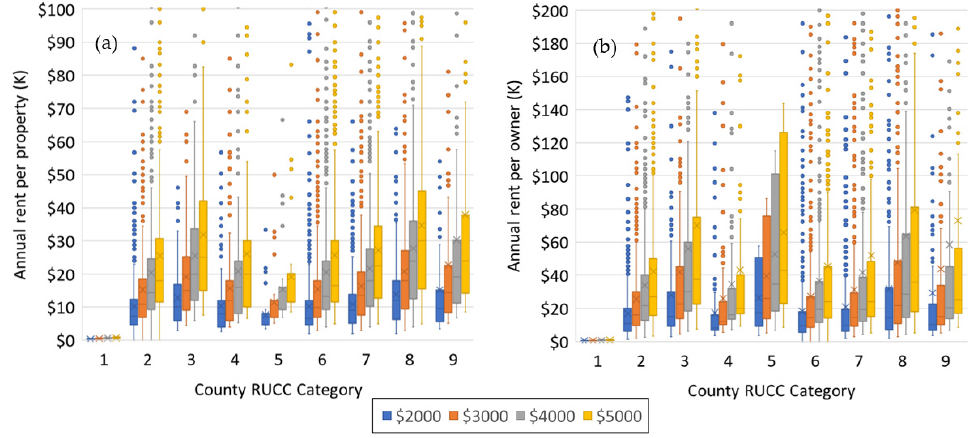
Figure 15. Assessment on the annual rent payments from wind turbine installed on individual lots in Texas categorized by USDA RUCC, classified according to ( a ) distinctive lots and ( b ) different owners.